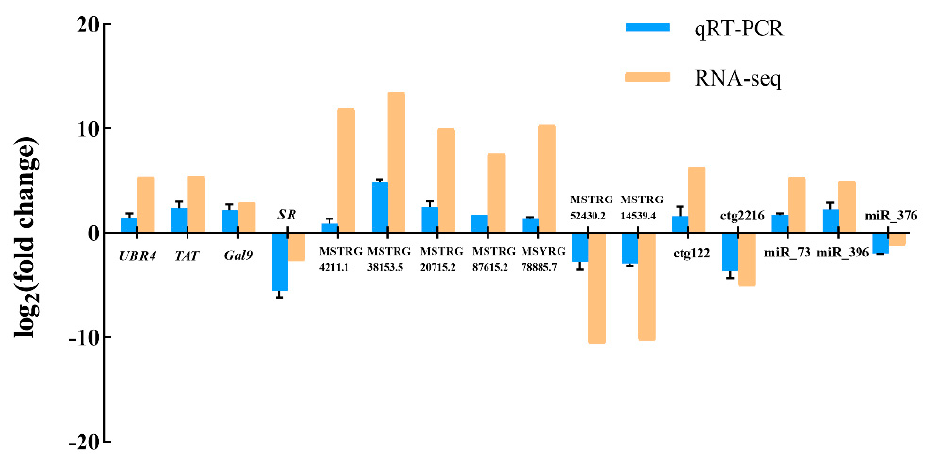
Figure 6. Validation of the RNA-seq data by qRT-PCR. The four on the left are DEGs, the next seven are DELs, the next two are DECs, and the three on the right are DEMis. The qRT-PCR data presented are the means ± SD of three biological replicates, and each measurement was repeated three times.